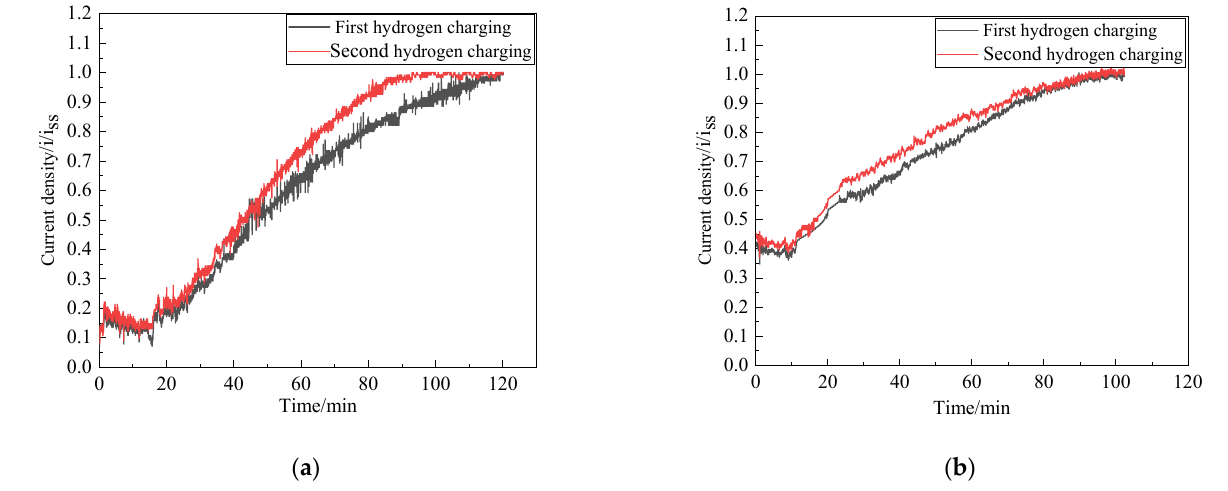
Figure 7. Variation of normalized current density with time. ( a ) Material A; ( b ) Material B.